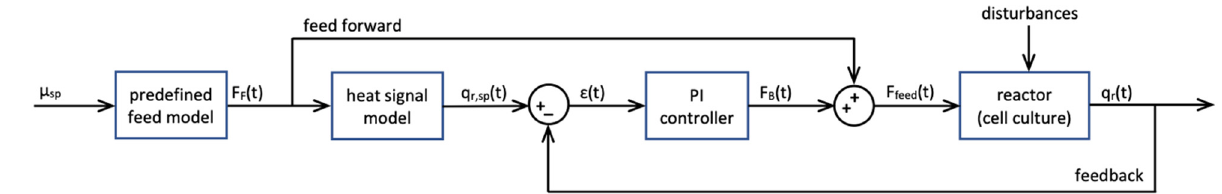
Figure 2. Calorimetry-based controller block diagram for the cultivation of S. cerevisiae. The heat flow dynamic setpoint (q r,sp ) evaluated dynamically for a specified growth rate ( µ sp ) is compared to the measured heat flow generated by cells (q r ), yielding the controller error term ( ɛ ). The error term is used as entry variable of a PI controller, which returns a feeding rate feedback value (F B ). The addition of the feed-forward (F F ) and feedback (F B ) terms provides the final instantaneous feeding rate (F feed ).